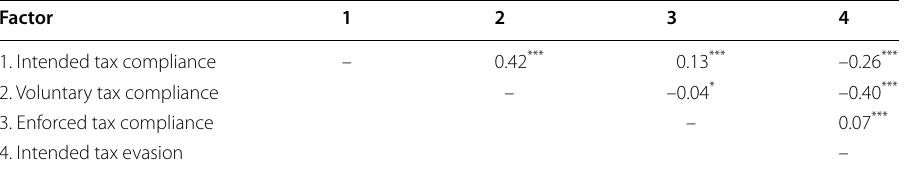
Table 2 Intercorrelations between tax compliance